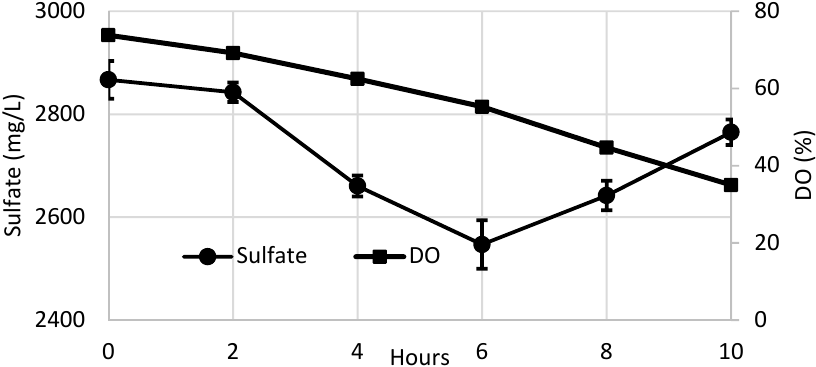
Figure 8. Variation of dissolved oxygen (DO) (in %) and sulfate of a slurry sample as a function of time.